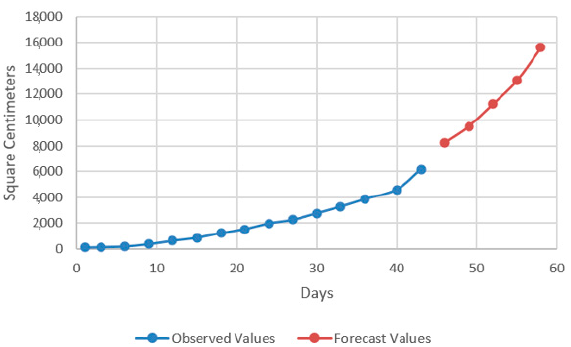
Figure 14. The evolution of basil leaves area in AR experimental variant.